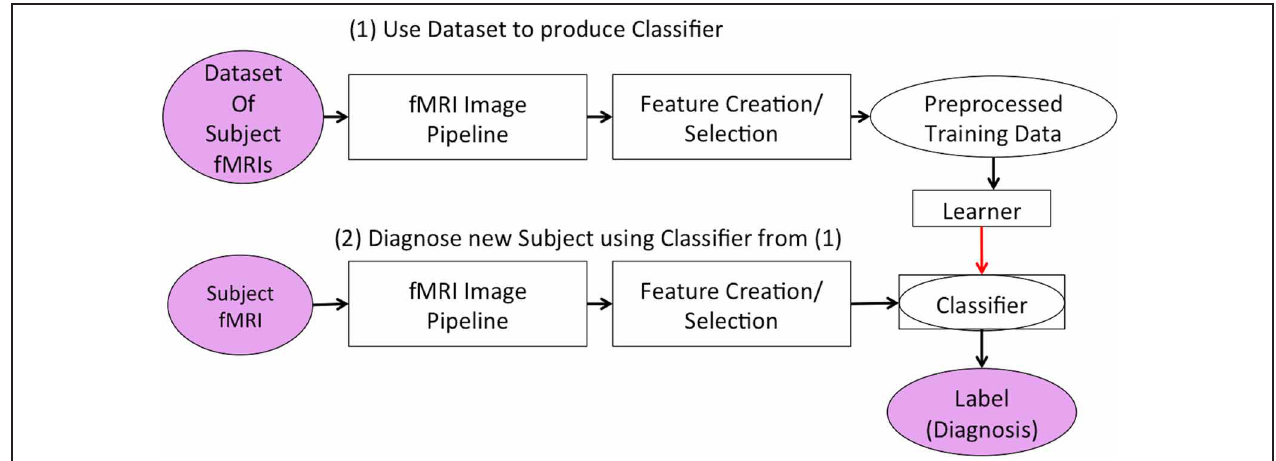
FIGURE 1 | Our learning system in two stages. The first stage developed the classifier responsible for diagnosing new subjects. The second stage used the classifier to generate a predicted diagnosis for a